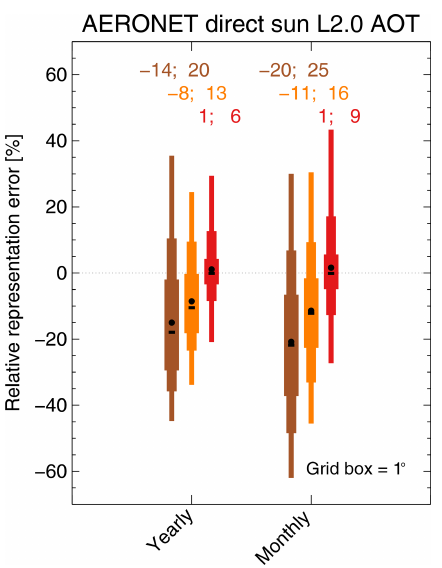
Figure 10. Yearly and monthly representation errors for AERONET direct sun L2.0 AOT, for a model grid-box size of 1 ◦ . In contrast to Fig. 4, only sites that provide observations 12 months out of the year are used in this analysis. The colours indicate different collo- cation protocols: yearly (brown), daily (orange) and hourly (red). Obviously, for the brown bar on the right, a monthly protocol was used. Numbers on top are the means of the errors and means of the signless errors.